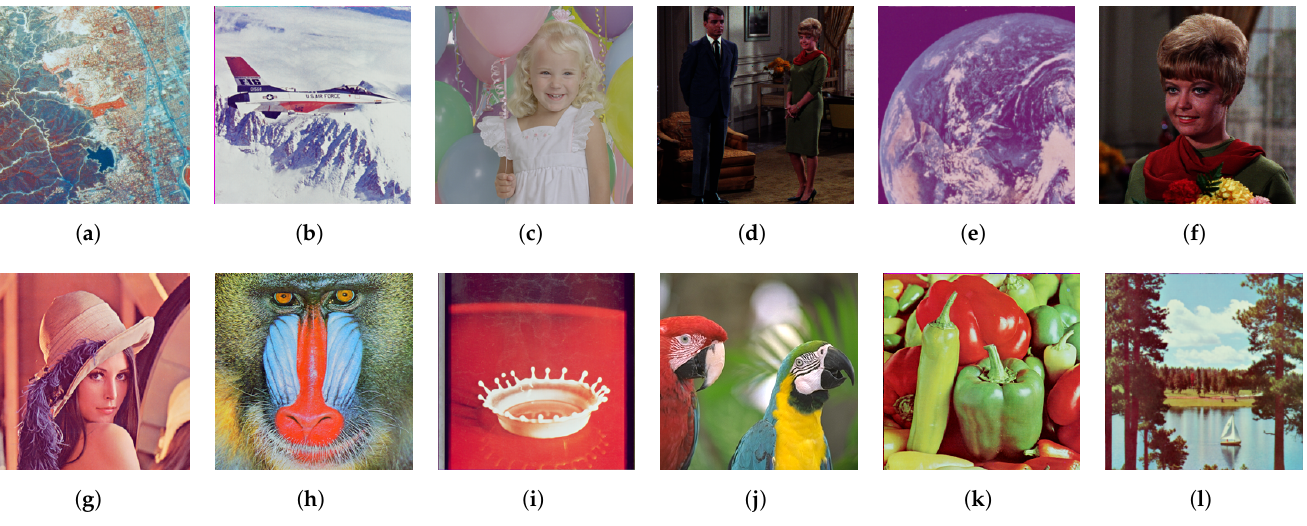
Figure 20. Color images in the SIDBA image dataset [28]: ( a ) Aerial, ( b ) Airplane, ( c ) Balloon, ( d ) Couple, ( e ) Earth, ( f ) Girl, ( g ) Lenna, ( h ) Mandrill, ( i ) Milkdrop, ( j ) Parrots, ( k ) Peppers, ( l )